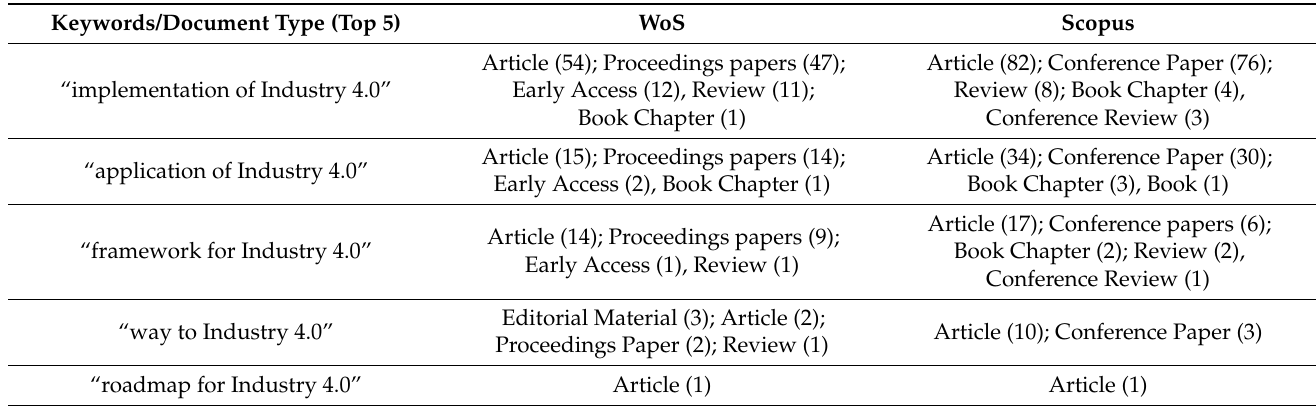
Table 6. Results of own literature review in the field: document type.